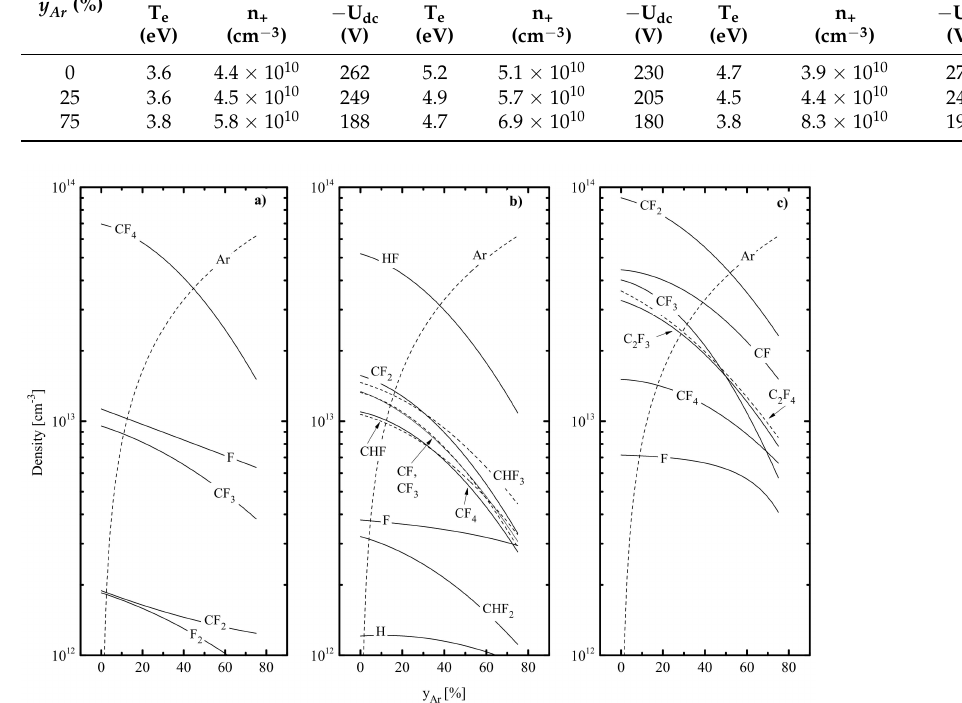
Figure 2. Densities of neutral species in CF 4 + Ar ( a ), CHF 3 + Ar ( b ) and C 4 F 8 + Ar ( c ) plasmas at p = 6 mTorr, W = 700 W and W dc = 200